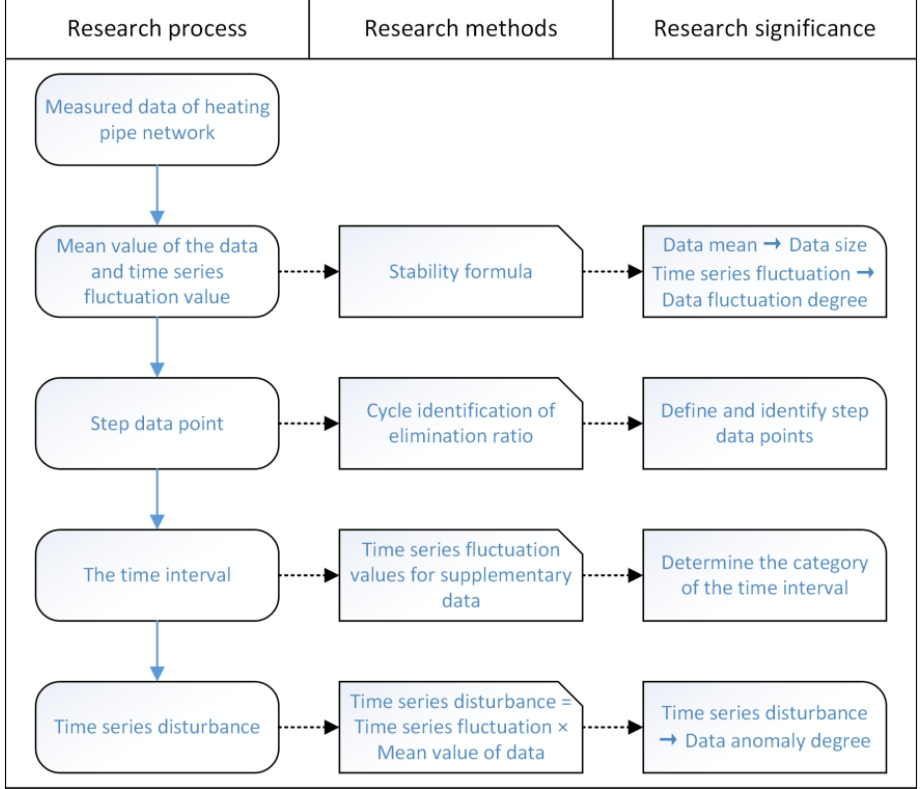
Figure 1. An outline of this